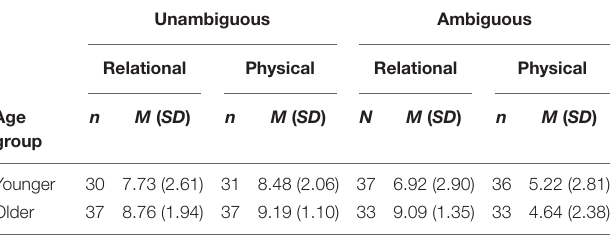
TABLE 1 | Means and SDs for intention attribution question [“How much did (transgressor) try ... ?”].